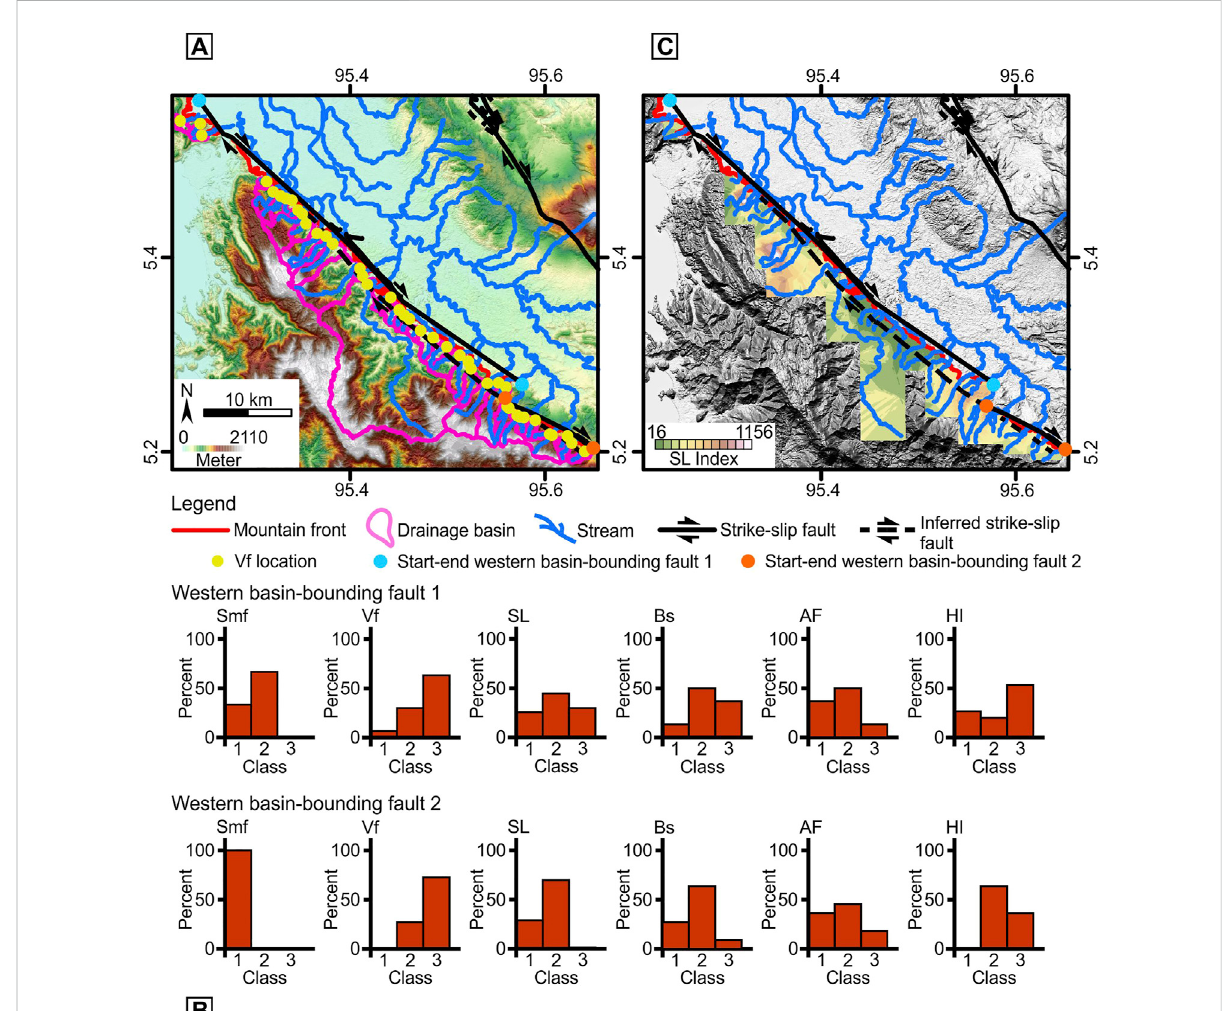
FIGURE 4 The Banda Aceh Basin: (A) the mountain fronts, faults, and drainage basins, (B) classi fi cation of geomorphic indices, and (C) stream length- gradient